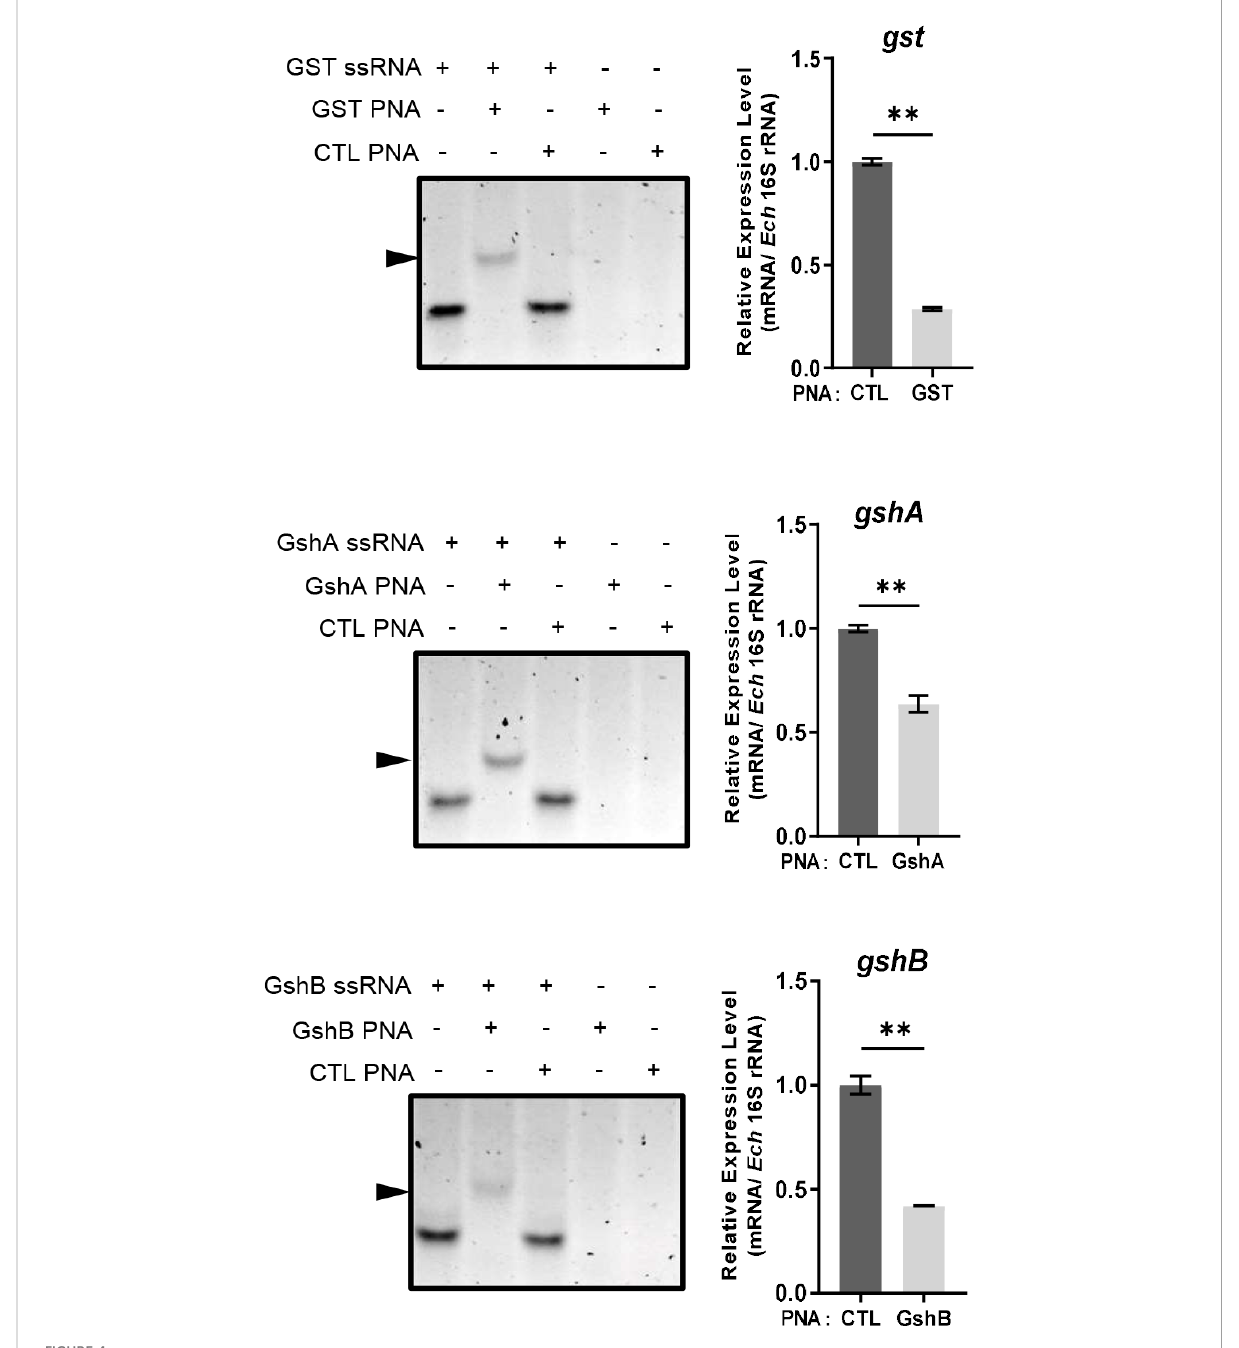
FIGURE 4 PNA transfection inhibits the expression of gst , gshA , and gshB respectively. GST PNA, GshA PNA or GshB PNA binds to its corresponding ssRNA (left). ssRNA probe (80 pmol) alone, with its corresponding PNA (80 pmol) or with CTL PNA (80 pmol) was annealed from 95 °C to 20 °C. The same amount of corresponding PNA (80 pmol) or CTL PNA (80 pmol) alone was treated at the same condition. Shifted bands are indicated by arrows. The expression levels of gst , gshA and gshB were determined with qRT-PCR and normalized against that of E. chaffeensis 16S rRNA (right). Relative values to the amount of CTL PNA-transfected E. chaffeensis are shown. Data indicate means ± standard deviations ( n = 3). The signi fi cant differences are represented by P -values determined with Student ’ s t test (** indicates P <